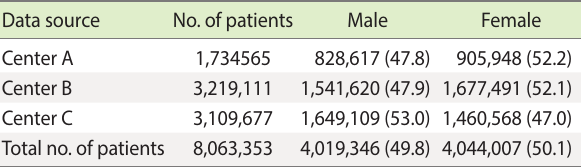
Table 1. Characteristics of the population included in the OMOP CDM databases from 3 tertiary referral